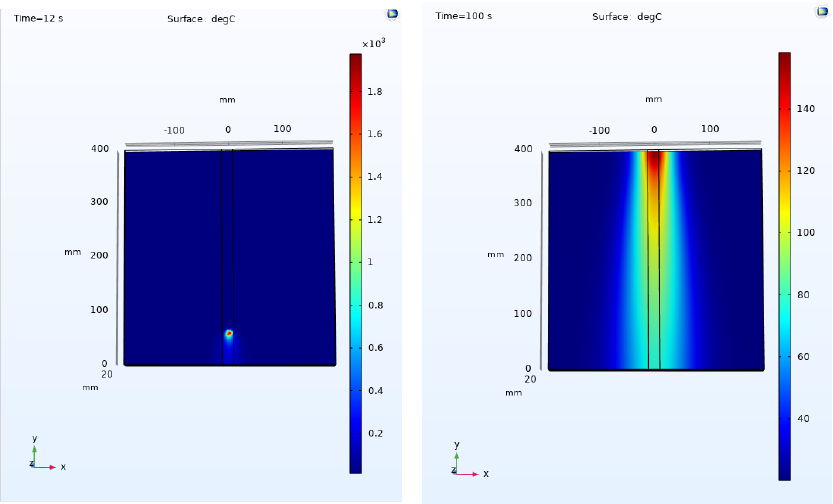
Figure 2. Application of heat source to butt welds.